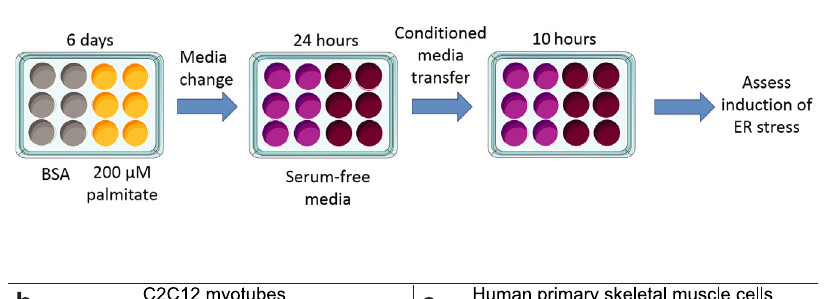
fractions of conditioned media from both control and palmitate- treated myocytes were reconstituted in serum-free media and transferred on to naïve differentiated myotubes. The aqueous metabolite fraction of media from palmitate-treated myotubes also increased the expression of UPR target genes compared to the aqueous fraction of media from control myotubes (Supple- mentary Fig. 1e). These data suggest that both a bioactive lipid(s) and metabolite(s) may function as cell non-autonomous UPR- inducing secreted signals.